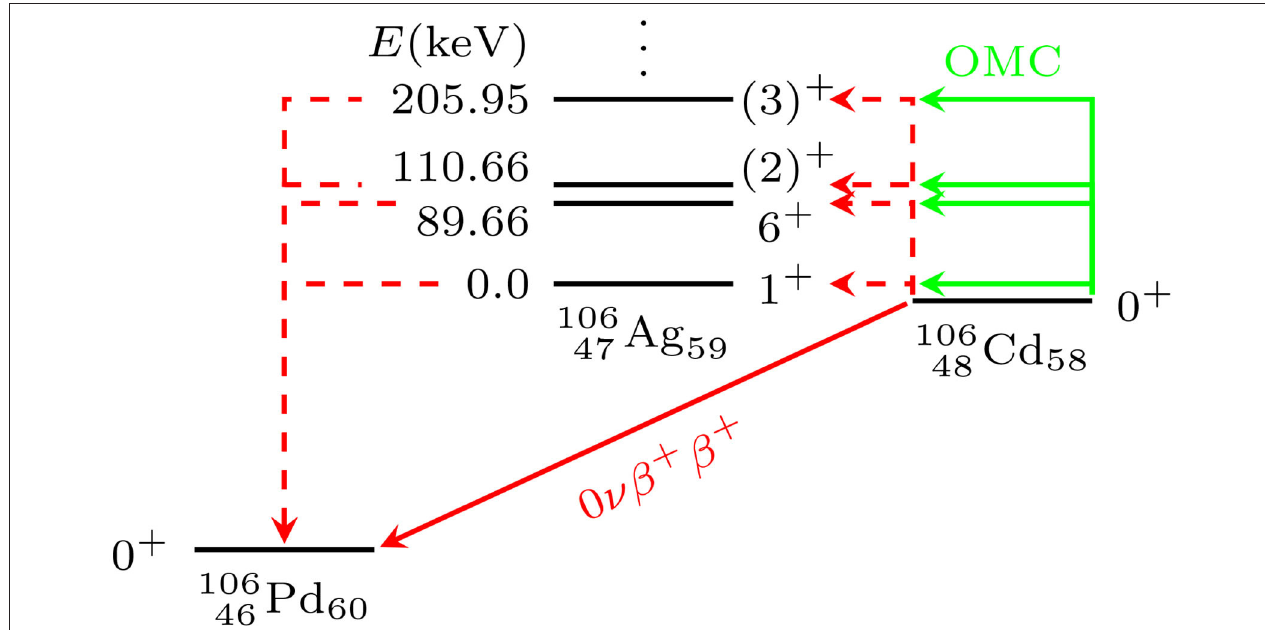
FIGURE 1 | Level scheme of the A = 106 system. The solid red line indicates the 0 νβ + β + -decay transition from the ground state of 106 Cd to the ground state of 106 Pd, and the dashed red lines refer to virtual transitions related to the 0 νβ + β + decay. The green lines correspond to OMC on the ground state of 106 Cd leading to different excited states of 106 Ag. The excitation energies of 106 Ag are shown in units of keV.